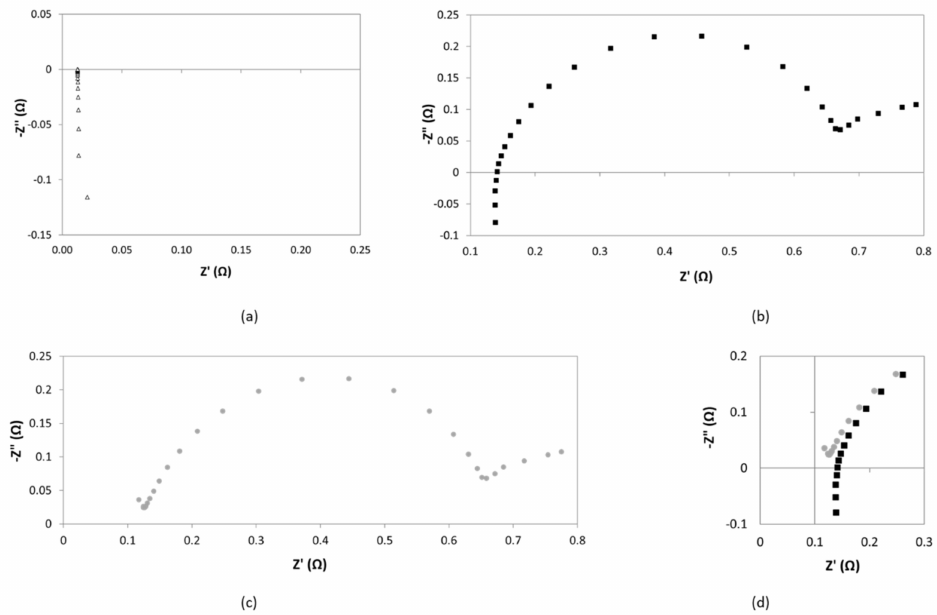
Figure 12. Correction procedure. Nyquist plots of ( a ) short circuit, ( b ) experimental data without correction, ( c ) experimental data after correction with inductance and ( d ) high frequency zone before and after correction.